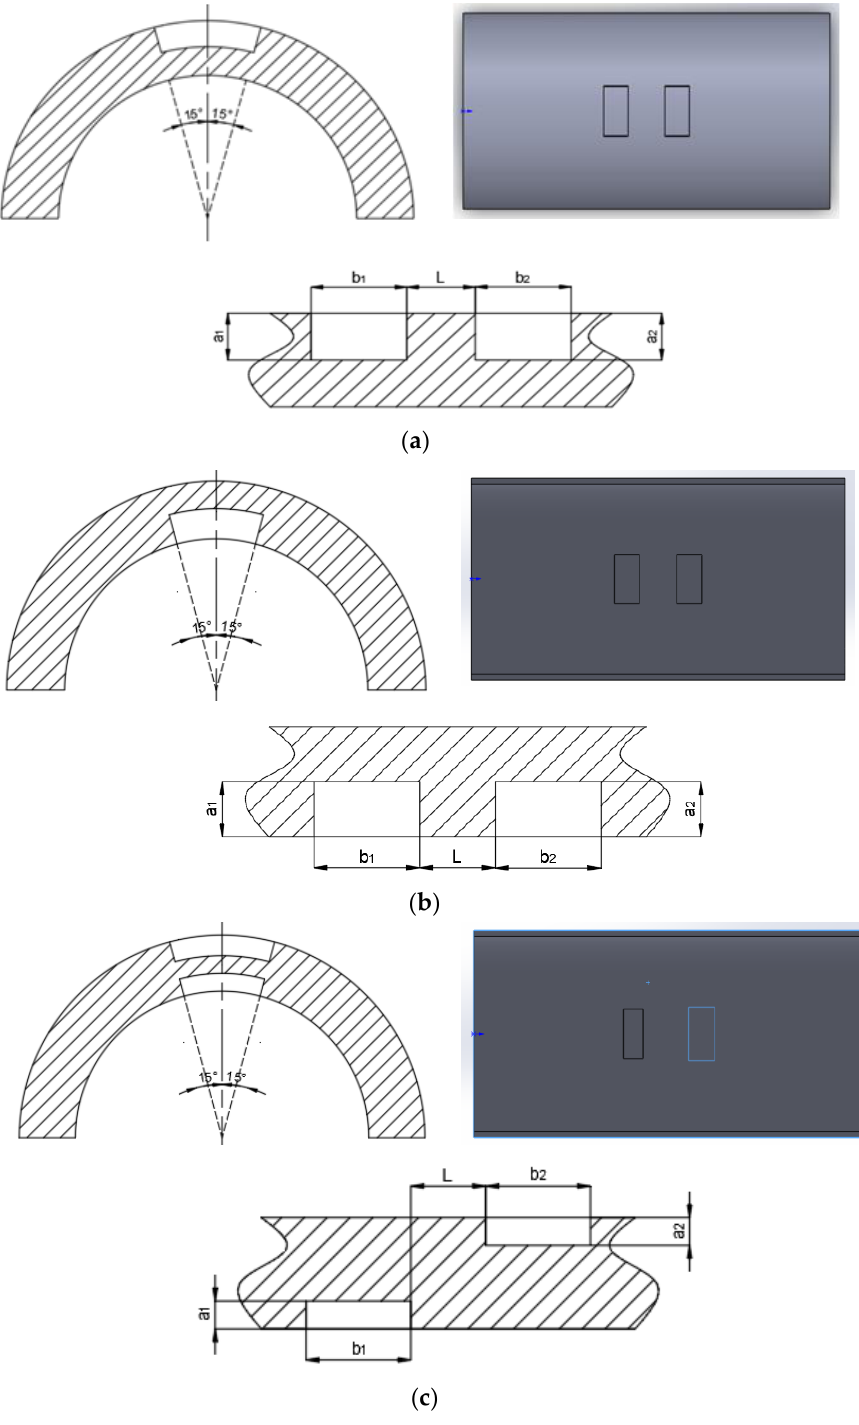
Figure 3. Geometric model of different types of double defects: ( a ) the exterior wall; ( b ) the interior wall; ( c ) the interior and exterior walls.